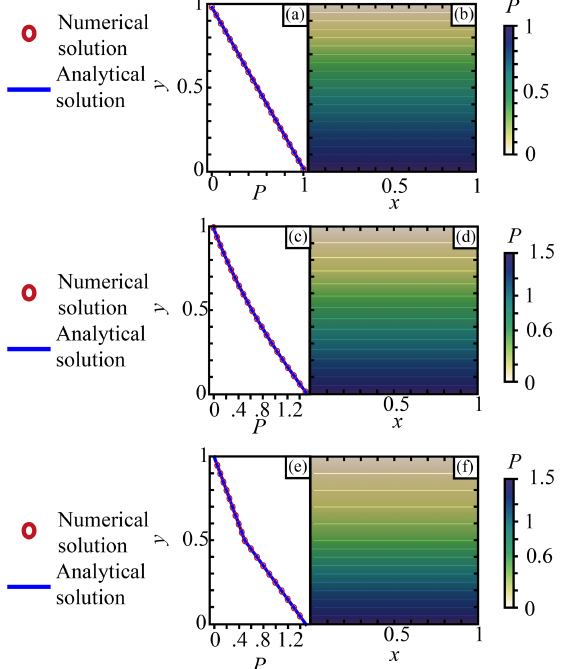
Figure 3. Pressure for a hydrostatic case in a half annulus approx- imating a simplified and idealized layered Earth. (a) Density struc- ture for the half-annulus model. (b) Numerical solution of the 2D half-annulus model. (c) The blue line shows the 1D analytical solu- tion for the density structure shown in (a) along a line parallel to the gravity vector. The red circles show the numerical solution extracted from (b) at coordinate x = 0 along a line parallel to the gravity vec- tor. (d) Green dots show the normalized error between the analytical | P d − P a | solution and the numerical solution at x = 0 as P d